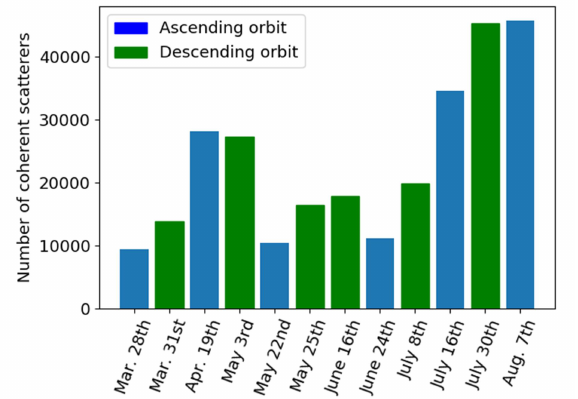
Figure 5. Number of detected coherent scatterers inside the Theresienwiese park at different dates using images acquired from two different